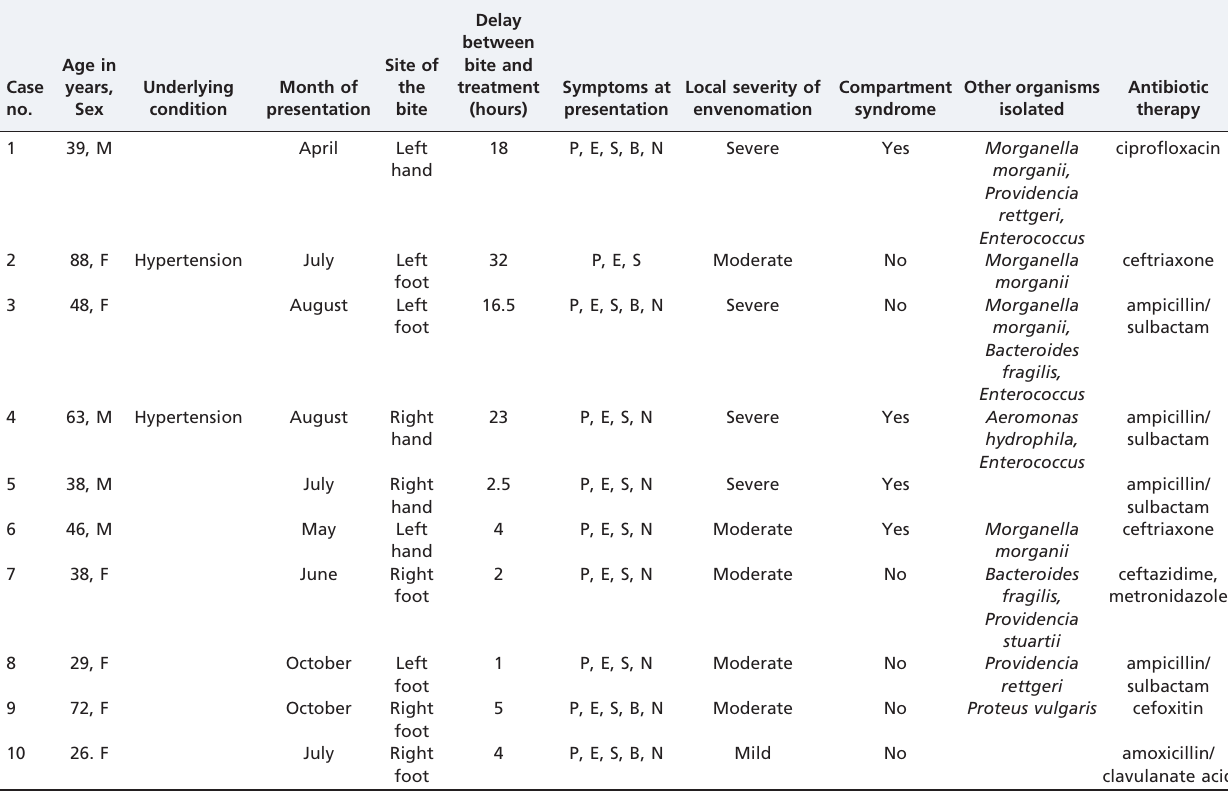
Table 1 - Clinical characteristics of 10 patients with a Shewanella infected wound from a cobra bite.